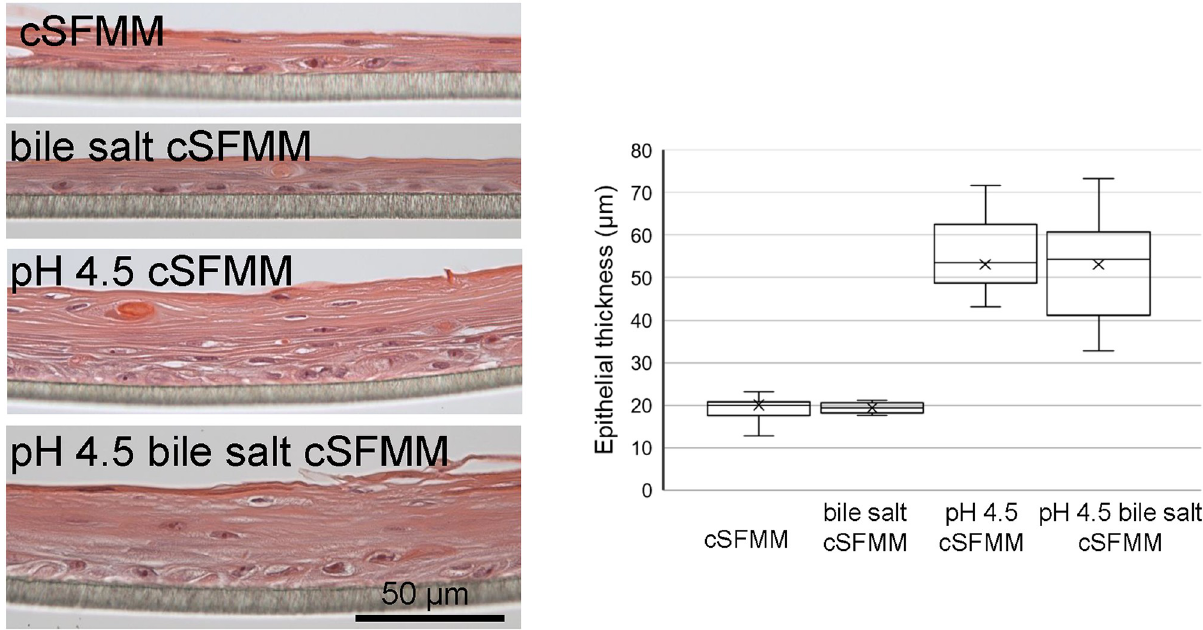
Fig 1. Effect of conditioned media from pH 4.5 and pH 4.5 bile salt treated HEMFs on the esophageal squamous epithelium in 3D OTC-ALI. pH4.5 bile salt treated HEMF conditioned media increases total epithelial thickness vs untreated serum-free, EGF-free HEMF conditioned media (cSFMM). (A). Representative images of three independent, reproducible experiments are shown. Scale bar represents 50 μ m. (B). Box and whisker plot of data from three independent experiments is shown (minimum, maximum, lower and upper quartile, and median are shown in the box and whisker plot). Mean values are indicated by X. Total epithelial thickness is increased in the squamous epithelium established with conditioned media from pH 4.5 or vs pH 4.5 bile salt treated HEMFs vs conditioned media from untreated HEMFs or HEMFs treated with bile salts alone (mean values 53.0 μ m vs 53.1 μ m vs 20.0 μ m and 19.4 μ m, p < 0.005 for cSFMM vs pH 4.5 cSFMM and pH 4.5 bile salt cSFMM; p < 0.005 for bile salt cSFMM vs pH 4.5 cSFMM and pH 4.5 bile salt cSFMM).